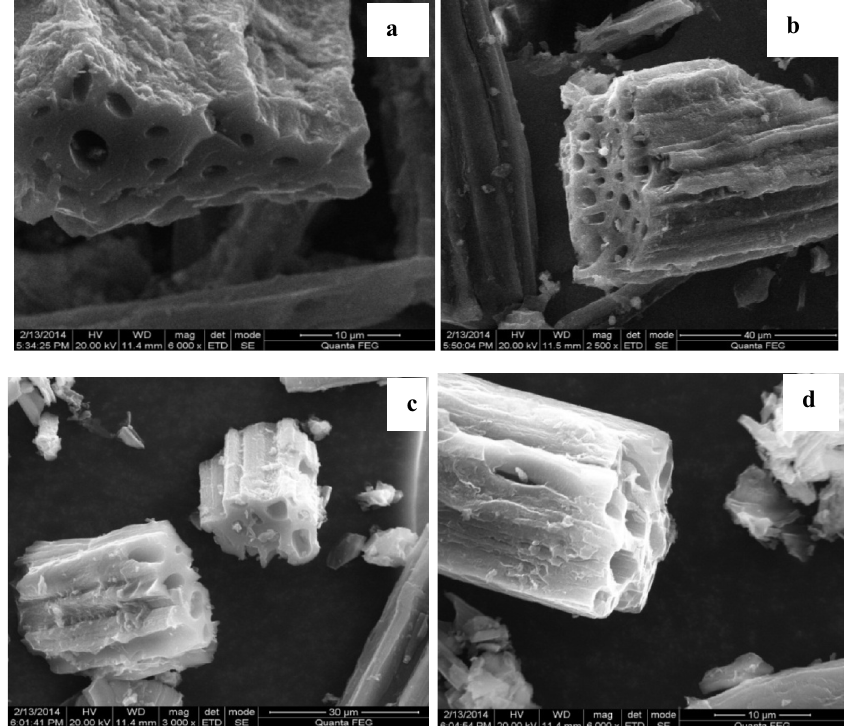
Fig. 1. SEM images of activated carbon from jute fi bers. (a) JUTE-700-1h, (b) JUTE-700-1:1, (c) JUTE-700-1:3 and (d) JUTE-700-